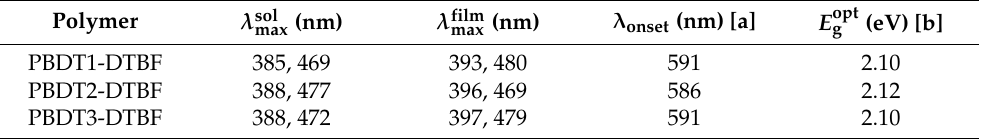
Figure 2. UV-visible absorption spectra of the polymers PBDT1-DTBF-DTBF, PBDT2-DTBF and PBDT3-DTBF ( a ) in the solution and ( b ) thin-film states. Table 3. Basic optical properties of PBDT1-DTBF, PBDT2-DTBF and